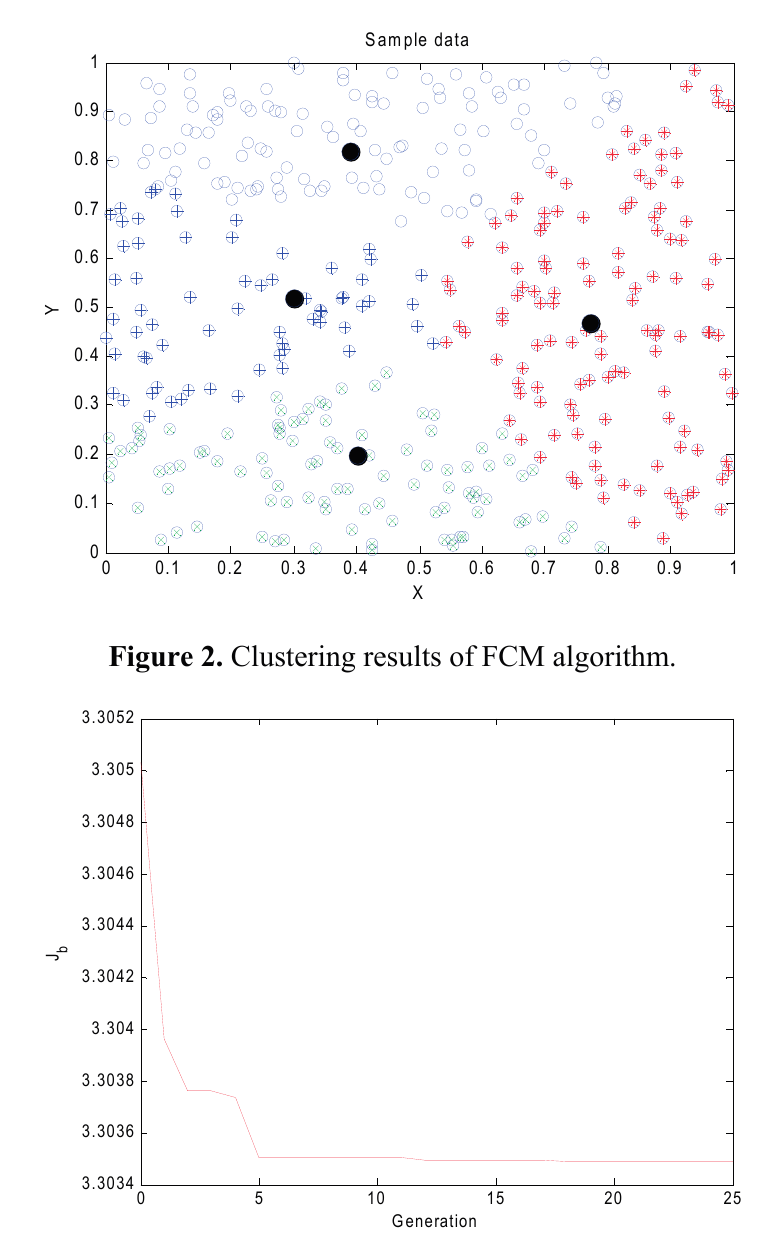
Figure 3. Optimization process for clustering problem of the KHE